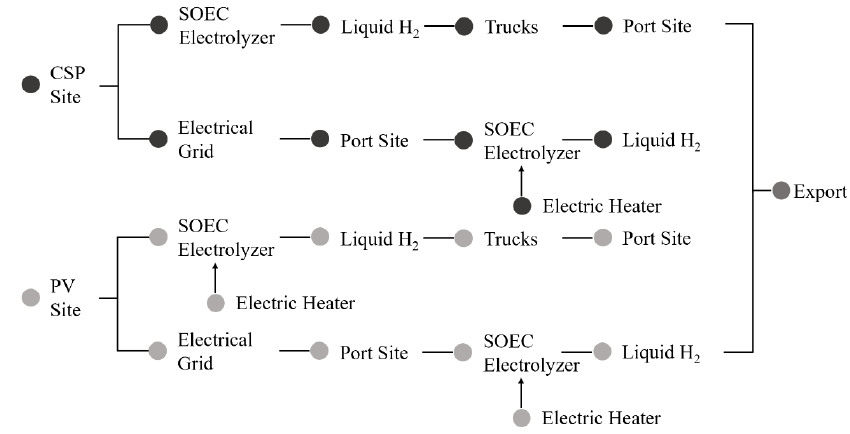
Figure 3. Scenarios’ layout.